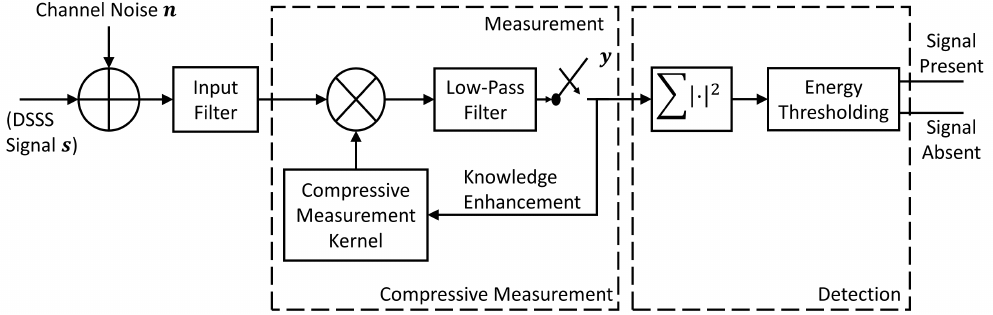
Figure 1. The Adaptive Compressive Measurement and Detection